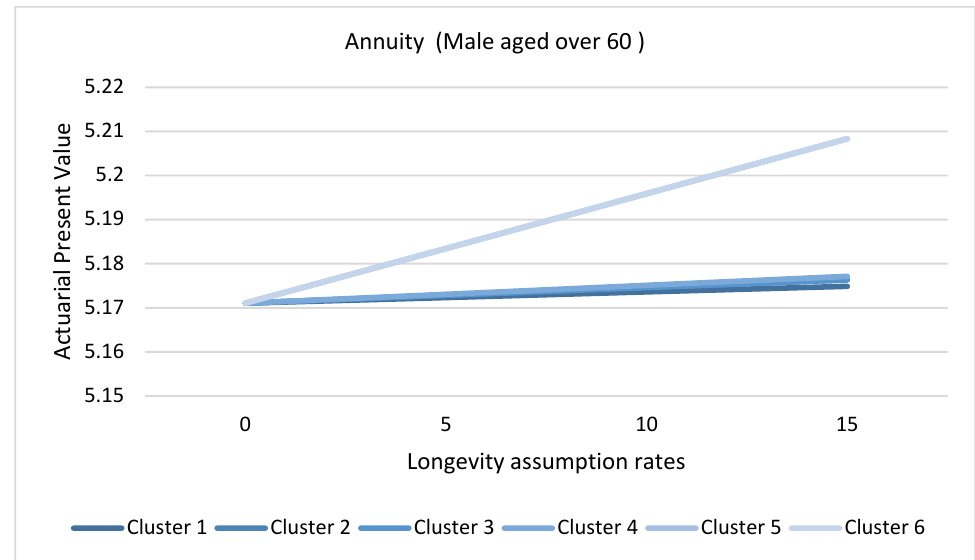
Figure 20. APV for males aged over 60 clusters against longevity assumption rates.